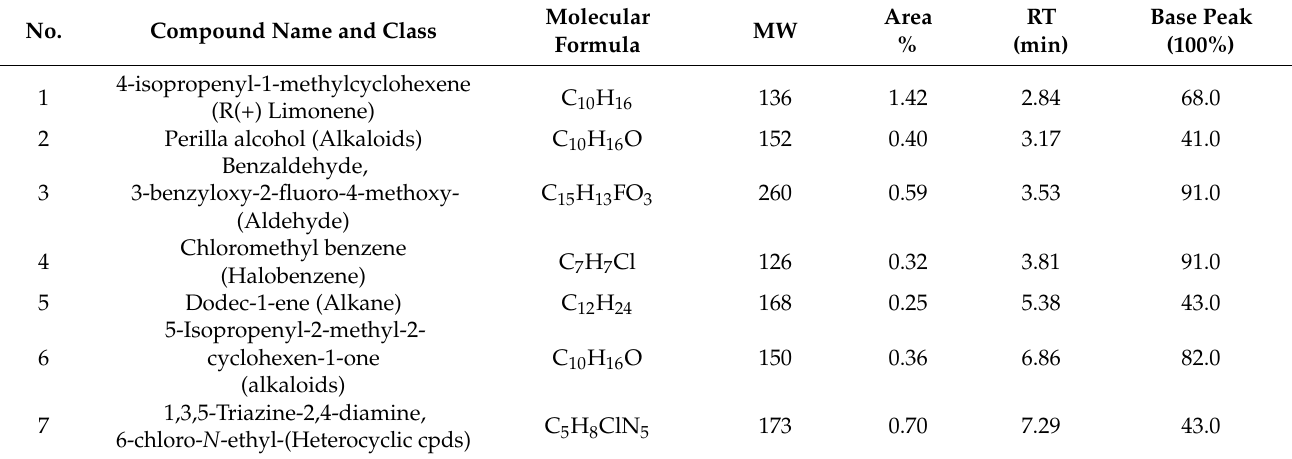
Table 5. List of identified bioactive compounds of endophytic B. velezensis extract by GC-MS